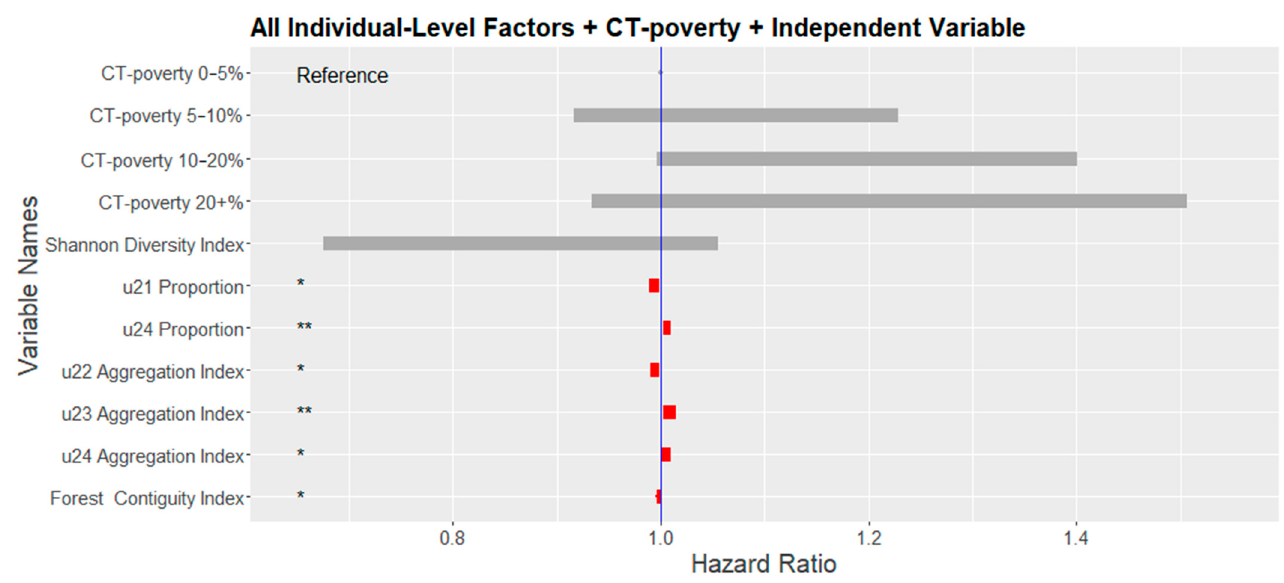
Figure 6. Hazard Ratios of neighborhood-level variables from the multivariate model adjusted for all individual-level factors and each neighborhood/landscape variable individually. Blue line indicates a zero-coefficient or no difference in risk. Red bars indicate the 95% confidence interval of statistically significant variables. (Note: Significance levels <0.05 = *; <0.01 = **; Land cover classes are based on the reclassified NLCD raster. U21 = Open, U22 = Low, U23 = Medium, U24 = High intensity developed lands).